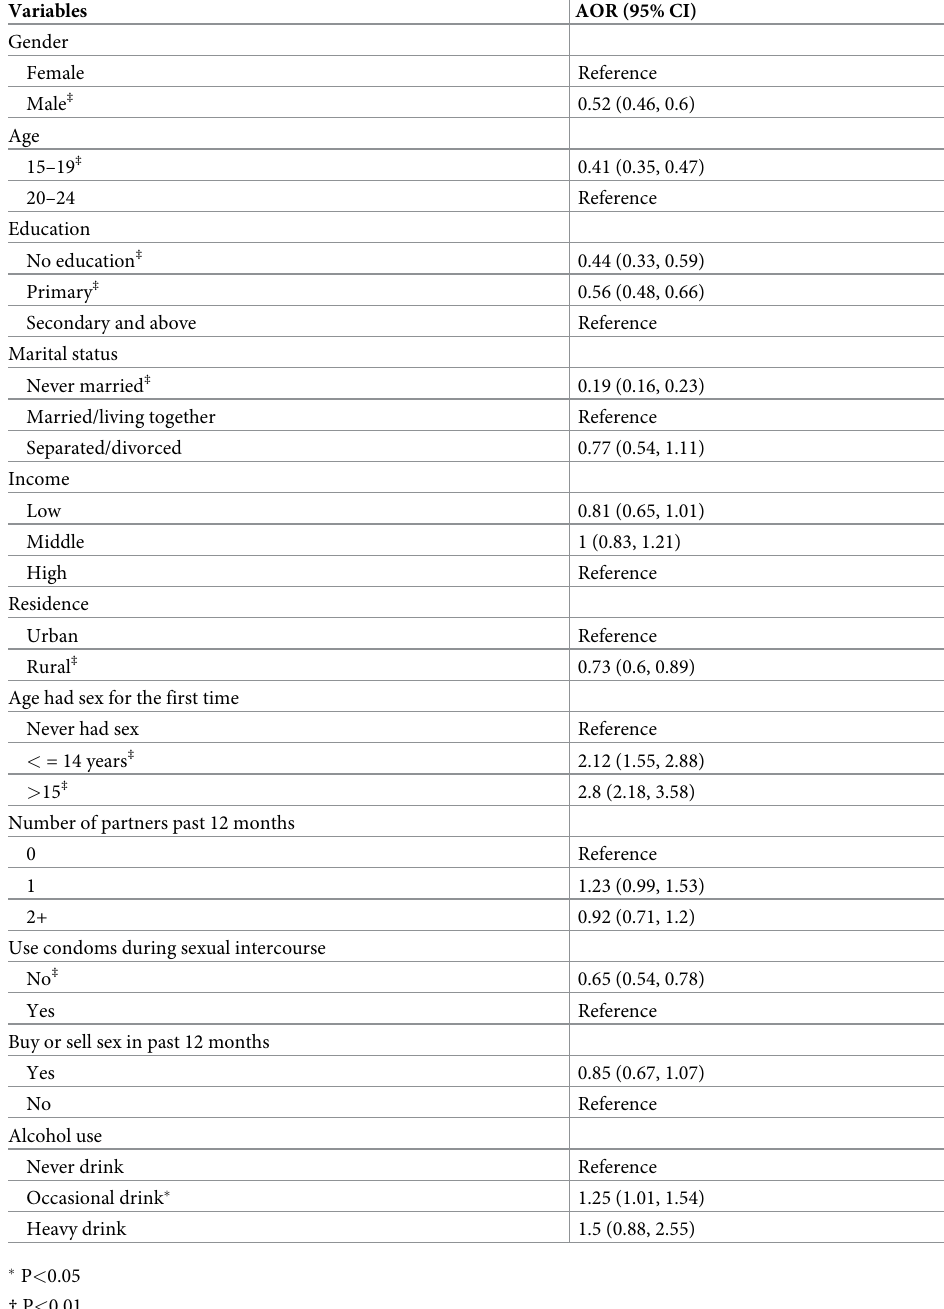
Table 3. Adjusted odds ratio (AOR) for demographic and socio-behavioral characteristics associated with ever having tested for HIV among adolescents and young adults aged 15–24 in Tanzania (N = 10.5 million).